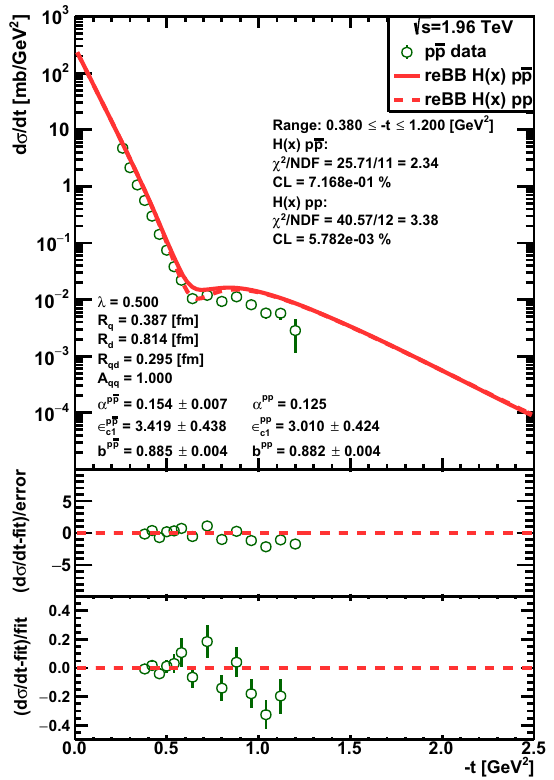
√ Fig. 27 Validation plot of the H ( x ) scaling at s = 1 . 96 TeV within the framework of the ReBB model. As indicated on this plot this con- straint is satisfied with a CL ≥ 0.1% for the measured p ¯ p data, in the limited − t range of validity of the ReBB model. Note that the rescaling (type C) coefficients for this comparison are rather large, outside their usual range of ( − 1 , 1 ) . This is why the data points are visibly below the best fitted curve, as in the upper panel of this plot, the datapoints were not rescaled/shifted by the rescaling coefficients of (cid:13) C . However, the good quality agreement between the rescaled data and the solid red line is indicated on the two lower panels, by the low values of the pull plots on the (data-fit)/error and on the (data-fit)/fit distributions. The agreement is statistically acceptable, as reflected also by the value of CL = 0.7%. The corresponding solid red line has only two free physical fit parameters, indicated by α( p ¯ p ) and b ( s ) , that are shown with their errors. A type C, overall normalization parameter is also allowed in this fit, that shifts all the datapoints up or down. The other three physical parameters are constrained by the H ( x ) scaling: R i ( s ) = b ( s ) R i ( s 0 ) , √ s 0 = 7 TeV. The difference between the with i = ( q , d , qd ) and solid red line and the dashed red line corresponds to the Odderon signal at this energy as for the pp case, this parameter is also constrained, α pp ( s ) = α pp ( s ) = 0 . 125 is a constant of s . This plot thus indicates, √ 0 s = 1 . 96 TeV may extend up to the full D0 that the H ( x ) scaling at √ s = 1 . 96 TeV acceptance with x max ( s ) = 20 . 2 at